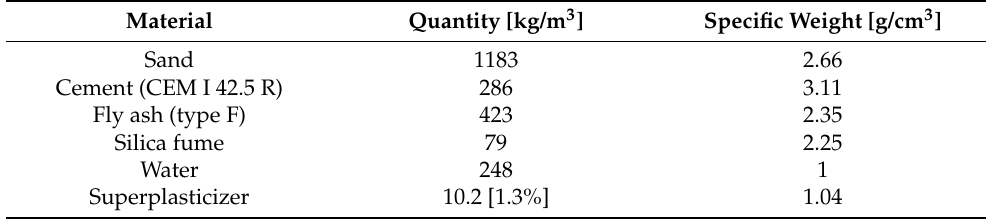
Table 1. Ternary mortar mixture